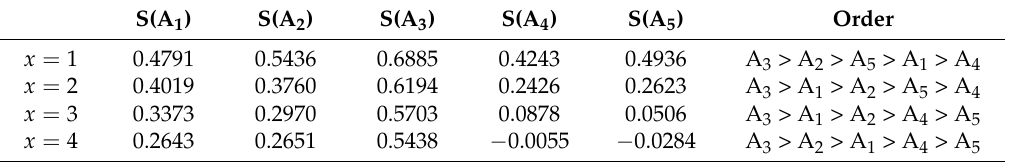
Table 5. The ordering results for the IVIFWDHM operator with different parameters.